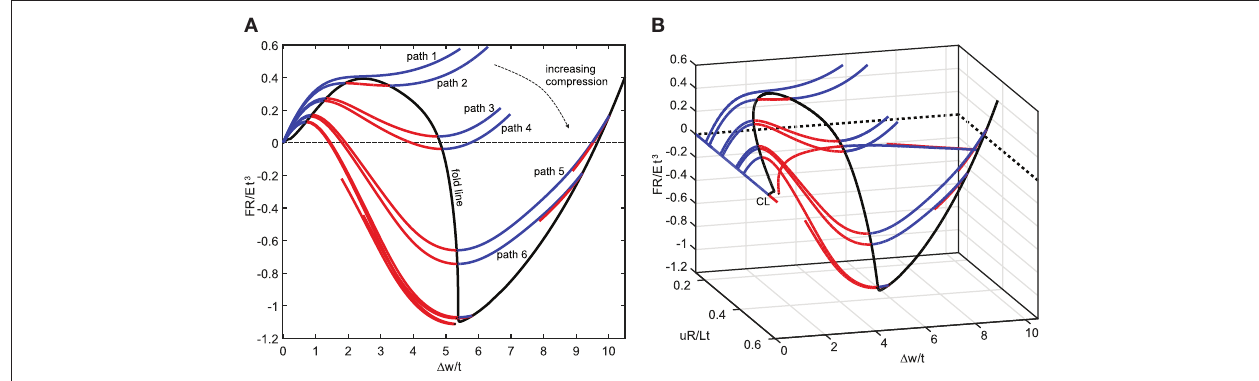
FIGURE 10 | The stability landscape of an axially compressed cylinder with a probing side force. (A) Normalized probe force ( FR / Et 3 ) vs. normalized probe displacement ( 1 w / t ) for different values of normalized axial compression ( uR / Lt ). (B) The stability landscape in terms of axial compression vs. probe force vs. probe